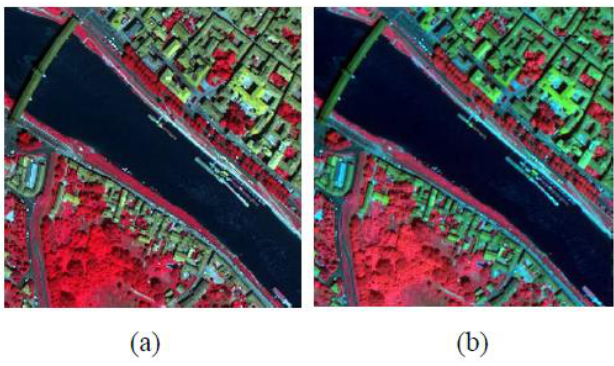
Figure 13. ( a ) MAP result in MTC; ( b ) Pansharpening result in PTC.